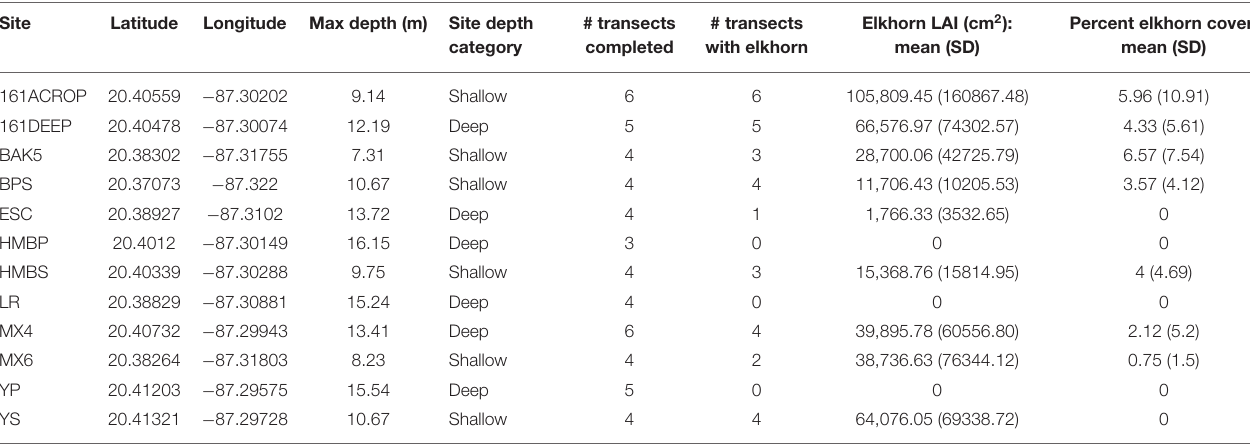
TABLE 1 | Elkhorn coral survey and demographic